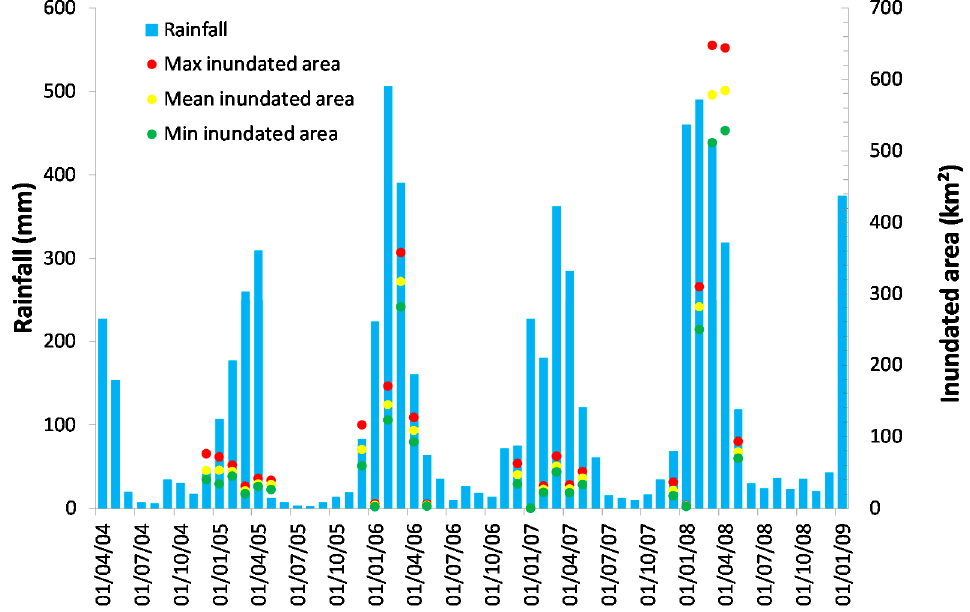
Figure 13. Time series of monthly rainfall (mm—blue bars) and inundation extent (km 2 ) for three threshold values applied to the normalized anomalies of backscattering coefficients ( σ 0 ) and corresponding to a minimal ( − 2.35—green dots), a mean ( − 2.30—yellow dots) and a maximal ( − 2.25—red dots) inundation area (km 2 ).